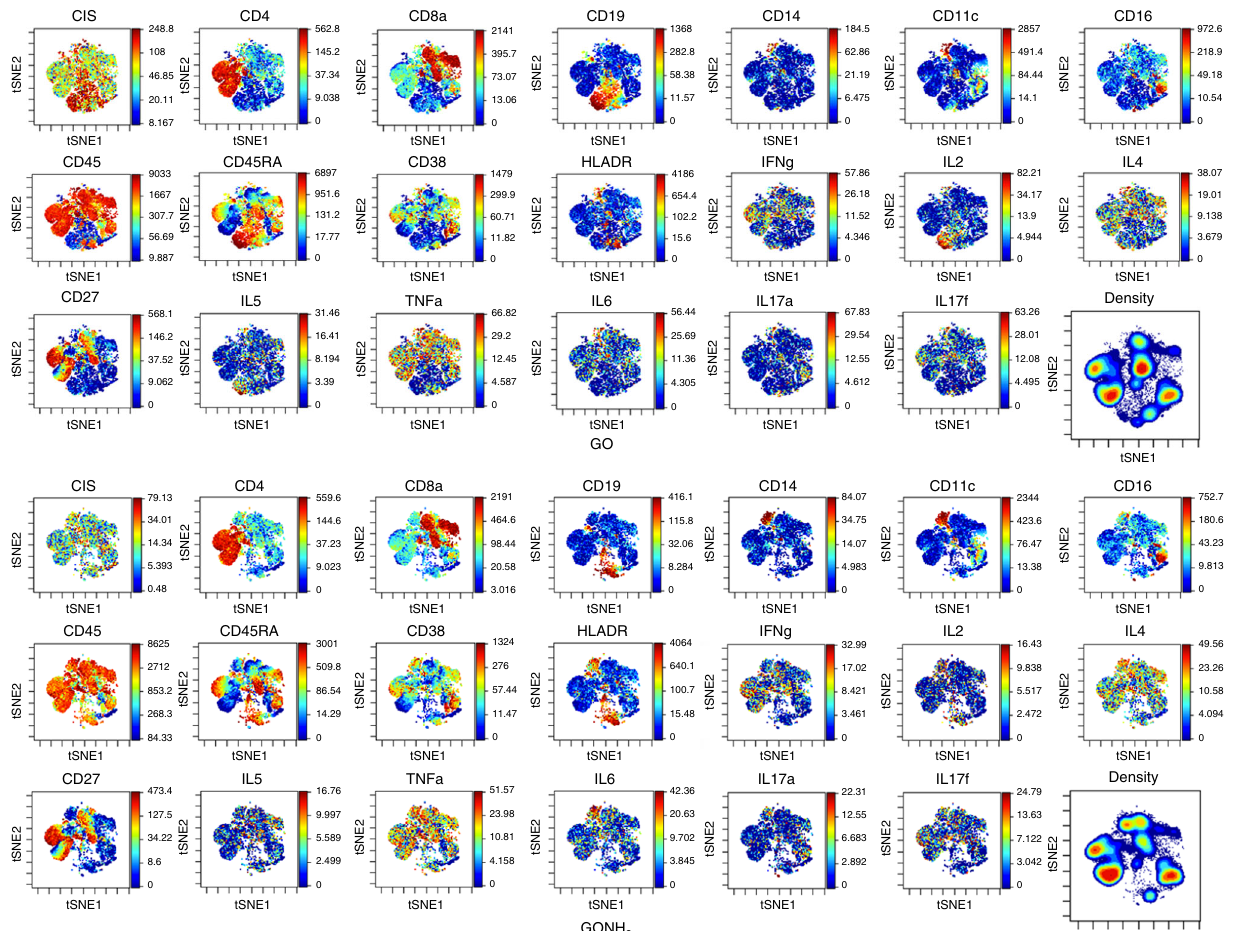
Fig. 4 Single-cell characterization of GO- and GONH 2 -treated PBMCs (viSNE analysis). Plots show the use of viSNE to obtain a comprehensive single-cell view and to distinguish the PBMC subpopulations in the GO- and GONH 2 -treated cells. Plots show expression of the 19 proteins, nucleic acid intercalator (CIS), and density measured per